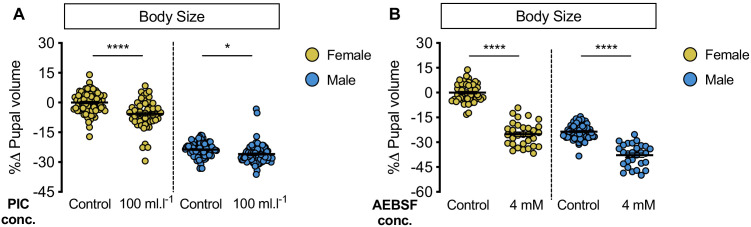
Pharmacological inhibition of protein breakdown has female-biased effects on body size.(A) Pupal volume was significantly higher in both w1118 females and males reared on a protein-rich diet (2Y) compared with genotype-matched females and males cultured on 2Y containing a broad-spectrum protease inhibitor cocktail (PIC) (p<0.0001 and p=0.0185, respectively; two-way ANOVA followed by Tukey HSD test). Importantly, the magnitude of the effect of inhibiting protein breakdown on pupal volume was higher in females (sex:treatment interaction p=0.0029; two-way ANOVA followed by Tukey HSD test). n = 57–92 pupae. (B) Pupal volume was significantly higher in both w1118 females and males reared on 2Y compared with genotype-matched females and males cultured on 2Y containing a serine protease-specific inhibitor 4-(2-aminoethyl)benzenesulfonyl fluoride hydrochloride (AEBSF) (p<0.0001 for both sexes; two-way ANOVA followed by Tukey HSD test); however, the magnitude of the effect of inhibiting protein breakdown on pupal volume was higher in females (sex:treatment interaction p<0.0001; two-way ANOVA followed by Tukey HSD test). n = 28–66 pupae. * indicates p<0.05; **** indicates p<0.0001; error bars indicate SEM.